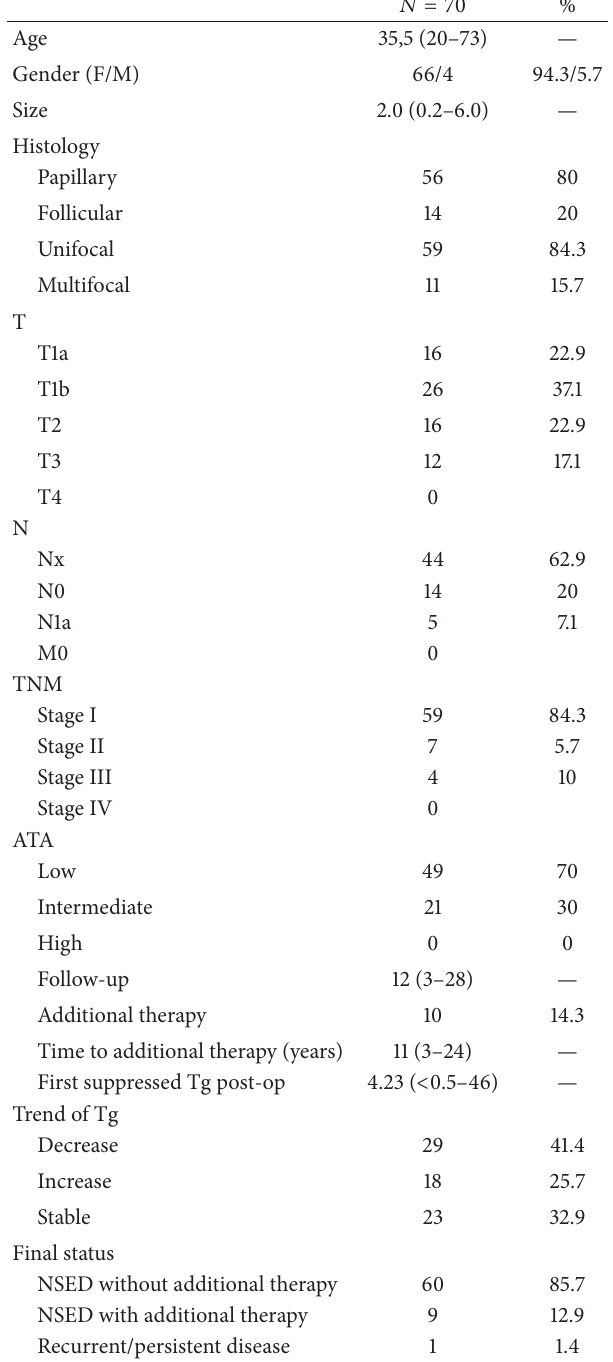
Table 1: Characteristics of the entire